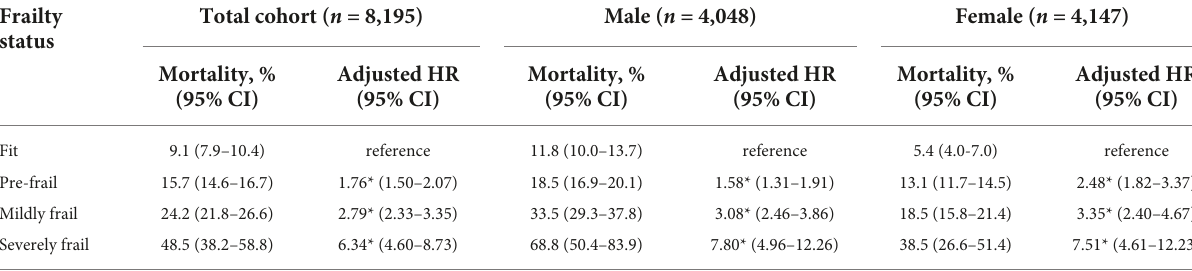
TABLE 3 The associations between 7 year all-cause mortality and frailty status among Thai older adults for all study participants, and compared between male and female who participated in the 4th Thai National Health Examination Survey (NHES-IV).